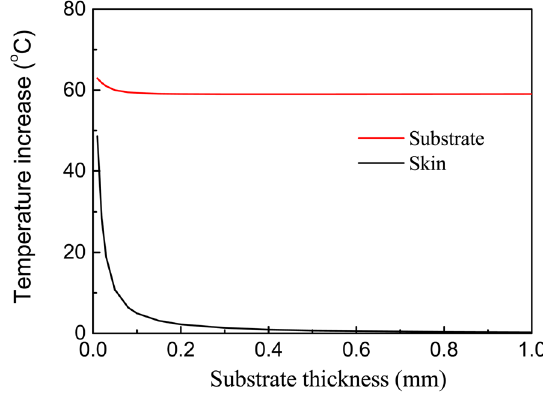
Figure 8. Effects of the substrate thickness on the μ -ILED temperature increase and the maximum skin temperature increase under a pulsed power with the duty cycle 50% and period 10 ms.